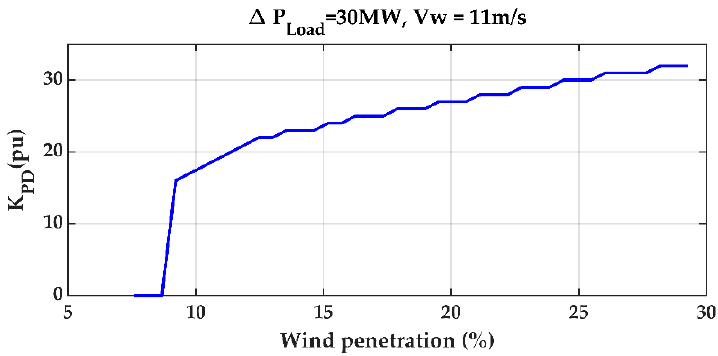
Figure 5. Optimal gain K PD as a function of wind penetration ( ∆ P Load = 30 MW and V W = 11 m / s).